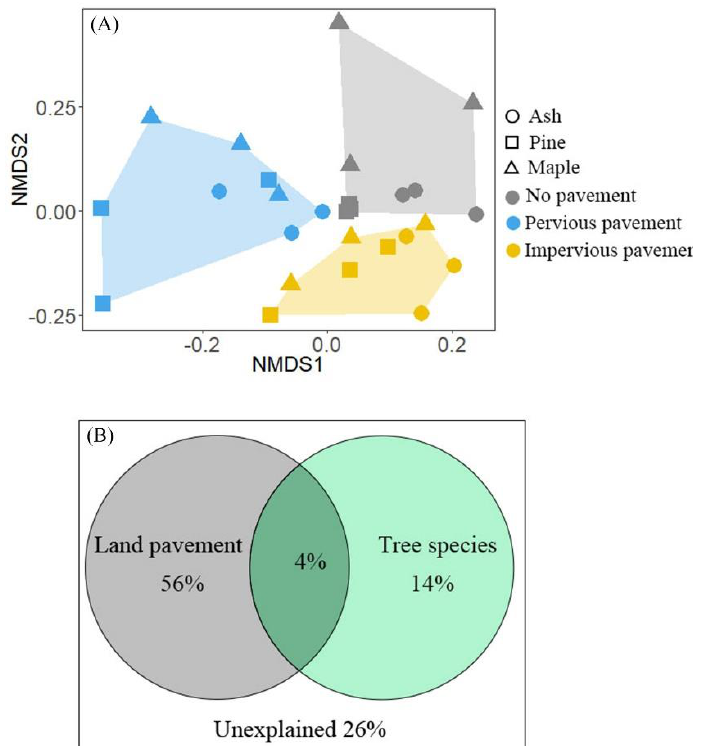
Figure 3. ( A ) Non-metric multidimensional scaling (NMDS) analysis based on the Bray-Curtis dissimilarity matrices showing the soil bacterial community composition sorted by pavement and tree species. ( B ) Variance partitioning analysis (VPA) results illustrate the proportion of variation explained in the bacterial community composition pavement, tree species, and the interactions between them.